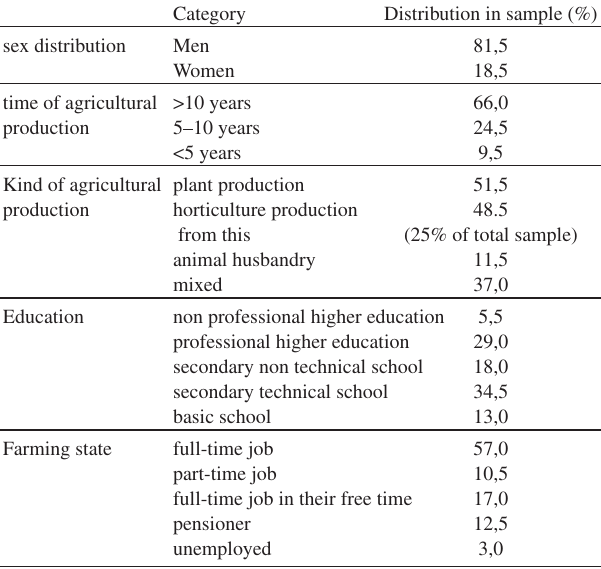
Table 1. The characteristic of sample